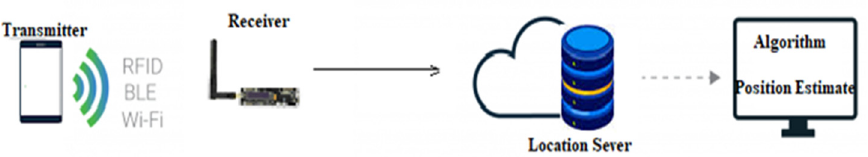
Figure 14. Architecture of IPS System.